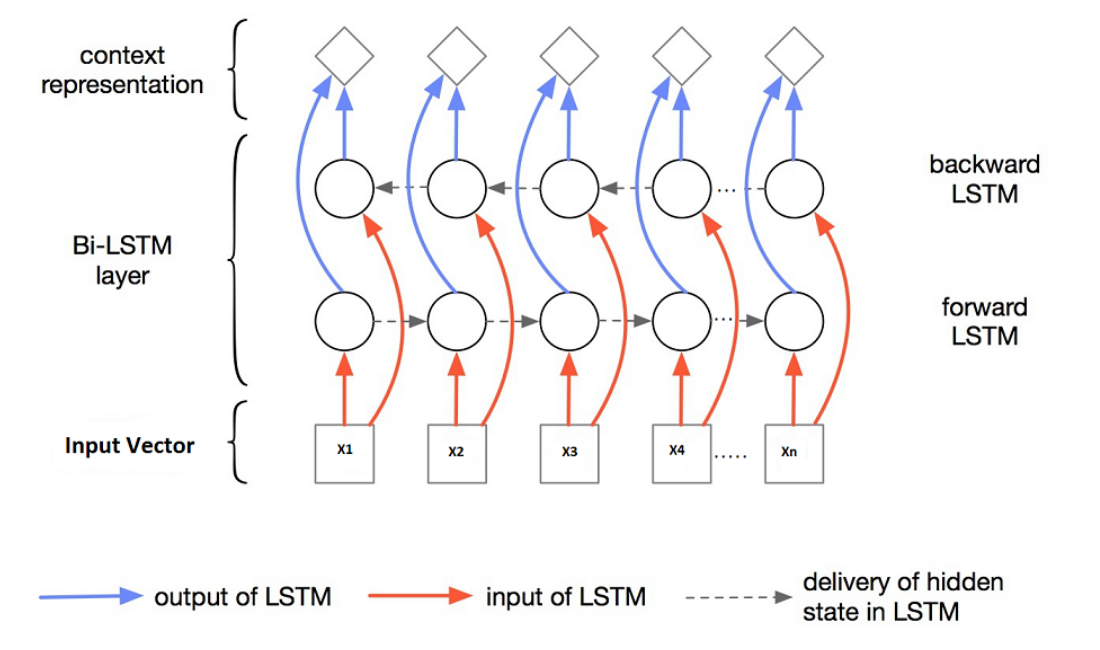
Figure 5. Bi-LSTM layer